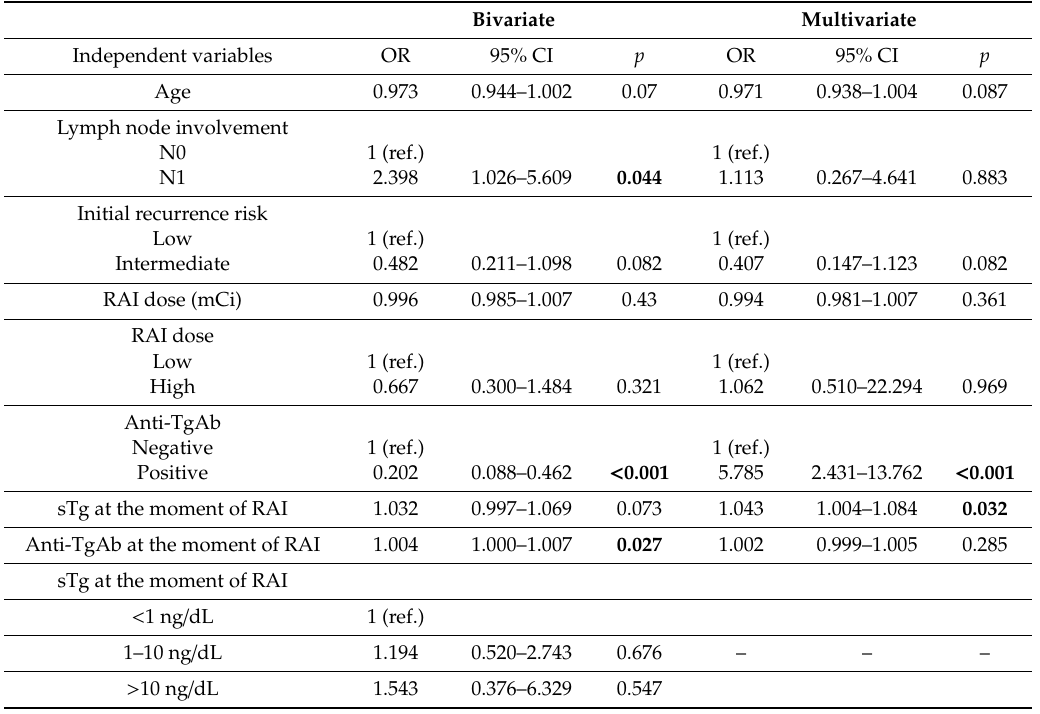
Table 2. Bivariate and Multivariate Logistic Regression Analysis—odds of nonexcellent response. Complete sample.